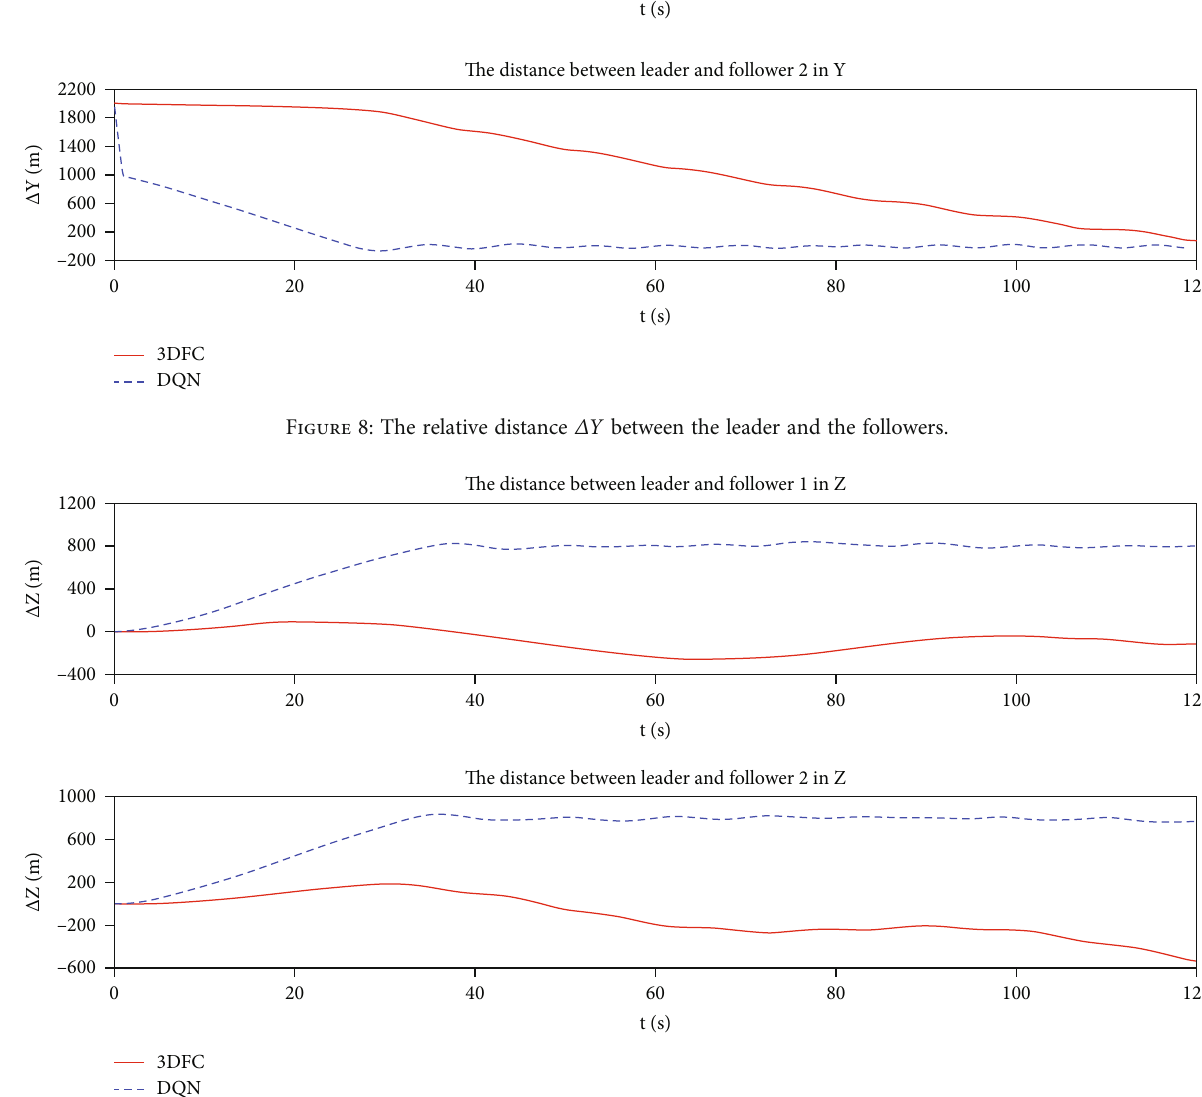
Figure 9: The relative distance Δ Z between the leader and the